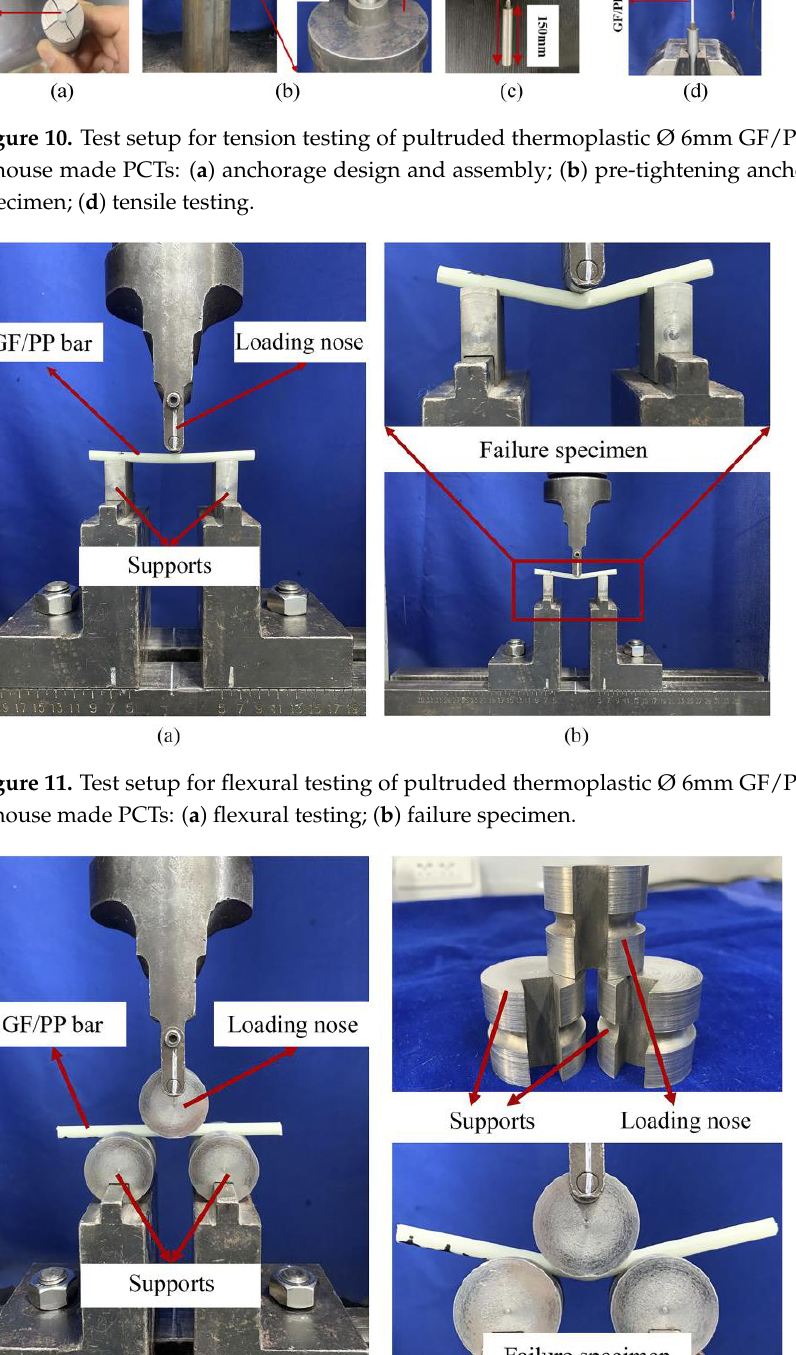
Figure 12. Test setup for short-beam shear testing of pultruded thermoplastic Ø 6 mm GF/PP bars based on inhouse-made PCTs: ( a ) short-beam shear testing; ( b ) failure specimen. Results of mechanical testing of pultruded thermoplastic GF/PP bars of Ø 6 mm and of 75 mm × 3.5 mm flat laminates are shown in Table 2 and Figure 13. The laminates produced from inhouse-made PCTs had higher flexural, tensile, and apparent interlam- inar shear strength compared to those made from commercial PCTs, by as much as 106%, 6.4%, and 27.6%, respectively. The lower quality of commercial PCTs as compared to the inhouse-made ones resulted in an inferior mechanical performance of the corresponding pultruded laminates. The injection method used for the production of commercial PCTs did not allow the uniform impregnation of glass fiber reinforcement by polypropylene resin. This resulted in the formation of un-impregnated regions and matrix cracks within the core region of fiber bundles in commercial PCTs. These defects, in turn, resulted in debondings and branched matrix cracks in the flat laminates based on commercial PCTs. On the contrary, the use of commingled yarns consisting of matrix and glass fibers properly intermingled over the whole length of the “prepreg” material mak ing it possible to achieve a more uniform impregnation of the inhouse-made PCTs and, therefore, to produce higher quality pultruded profiles. Figure 13. Mechanical properties of pultruded thermoplastic composites: ( a ) flexural and tensile strength; ( b ) modulus of elasticity in bending and elastic modulus.